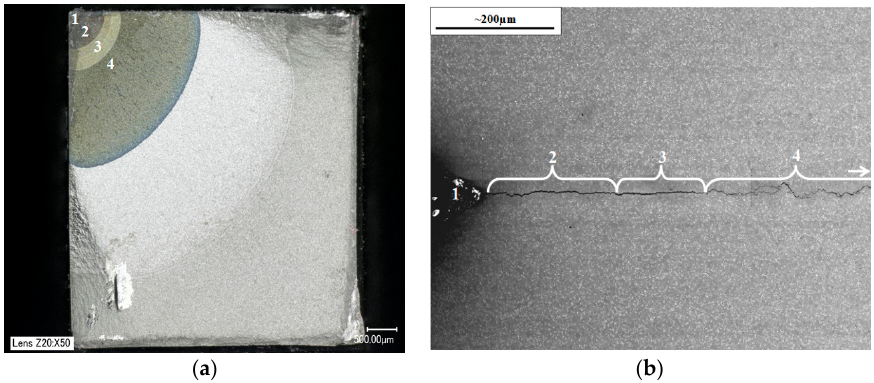
Figure 11. Normalised crack growth rates at a stress intensity range of ( a ) 20 MPa √ m and ( b ) 40 MPa √ m for RR1000 under TMF and isothermal conditions.